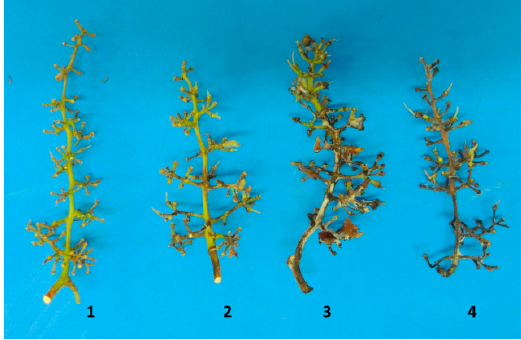
Figure 1. Stem browning scores of the ‘BRS Vitoria’ table grapes. 1: fresh and green; 2: light browning; 3: moderate browning; and 4: severe browning.